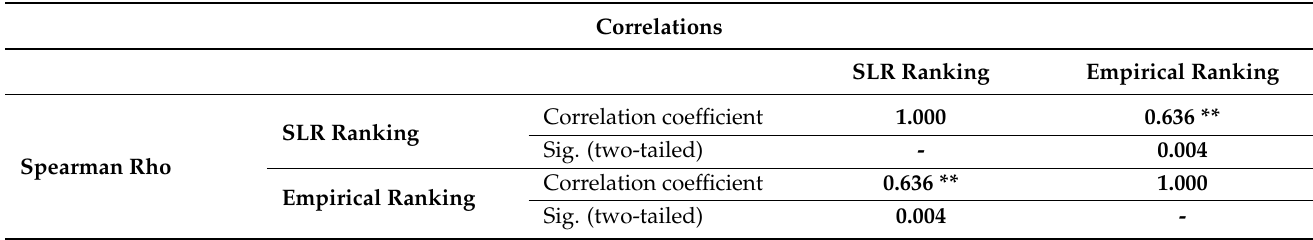
Table 10. Rank-order correlation between SLR and empirical studies.